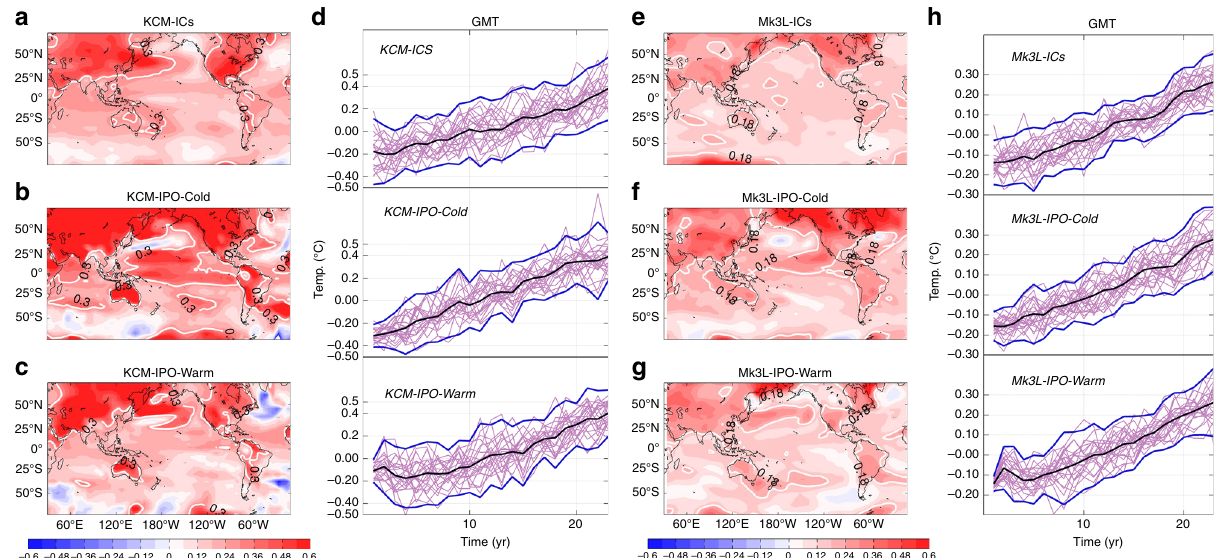
Fig. 5 Surface warming in randomly chosen and fi xed oceanic initial conditions experiments. Ensemble mean of 20-year trend in SAT ( a – c , e – g ) and time series of the GMT ( d , h ) obtained from the KCM-ICs ( a , d ), the KCM-IPO-Cold ( b , d ), the KCM-IPO-Warm ( c , d ), the Mk3L-ICs ( e , h ), the Mk3L-IPO-Cold ( f , h ) and the Mk3L-IPO-Warm ( g , h ) ensemble of global warming simulations. The SAT trends are computed the fi rst 20-year after initialization. d , h Thin (thick black) lines indicate the ensemble mean and thick blue lines denote ± 2 × standard deviation. The globally averaged SAT time series are relative to its average over the fi rst 20-yr. Please note that a – c and e – g have identical color-scale. Contours denote 0.3 and 0.18 °C/decade in a – c and e – g ,